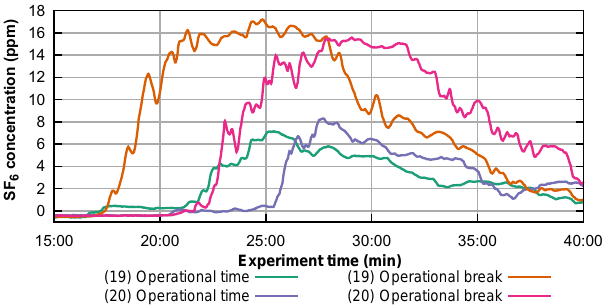
Figure 5. SF 6 concentrations at North Station. The numbers in parentheses contribute to the measurement points (see Fig.